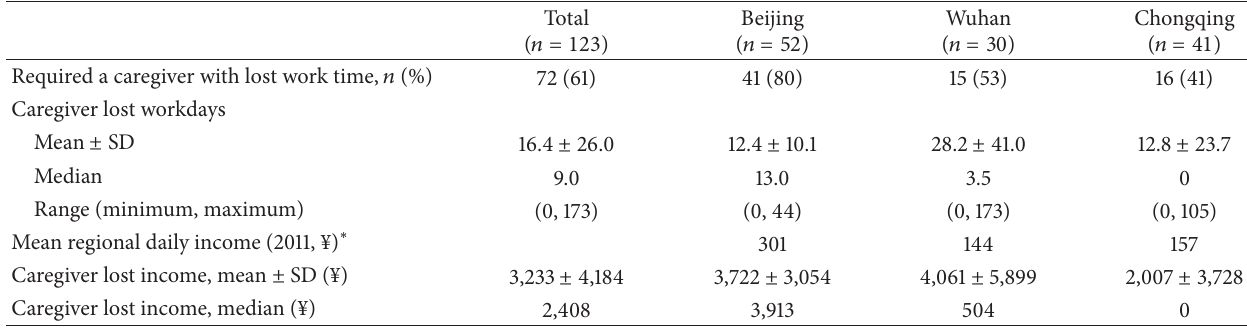
Table 4: Caregiver lost work time (days) and lost income (¥).